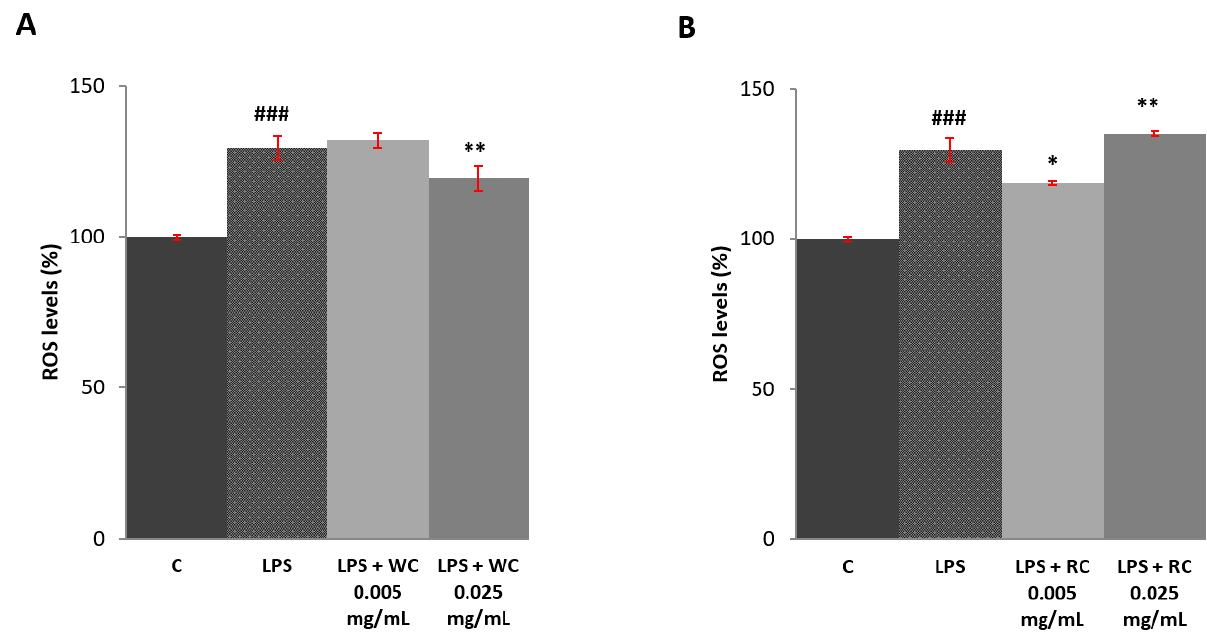
Figure 3. Effect of WC (panel A ) and RC (panel B ) on ROS production. U937 cells were triggered by 100 ng/mL of LPS in the presence or absence of WC or RC (0.025 mg/mL and 0.005 mg/mL). After 24 h, ROS levels were quantified. Results are presented as means ± SDs from three independent experiments. The comparison between the results are expressed as follows: * p < 0.05 vs LPS, ** p < 0.01 vs LPS, ### p < 0.001 vs control.